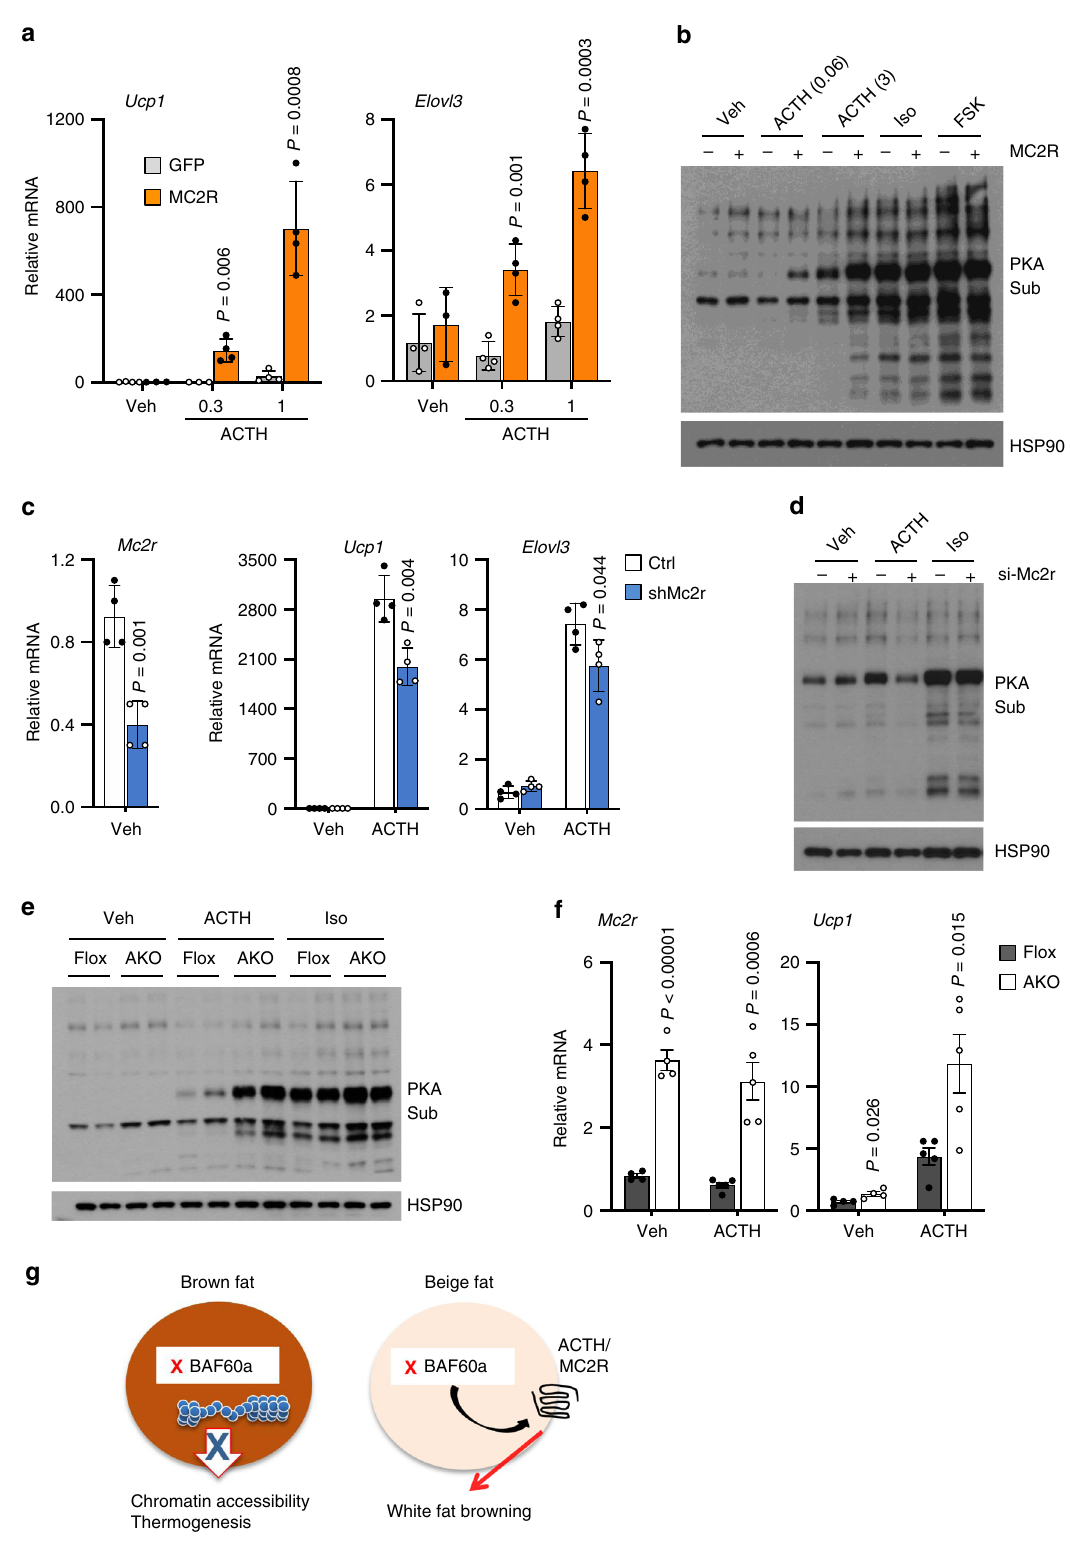
rotation. One microgram of antibodies against PPAR γ (sc-7196x, Santa Cruz) or control IgG was used for each binding assay. To recover the antibody-bound chromatin, Protein A agarose beads (Thermo Fisher Scienti fi c, #20334) were